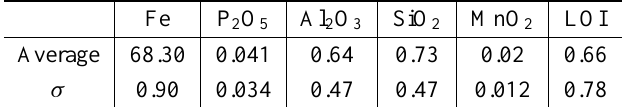
Average chemical composition of 21 samples from the Capitão do Mato Mine used for porosity